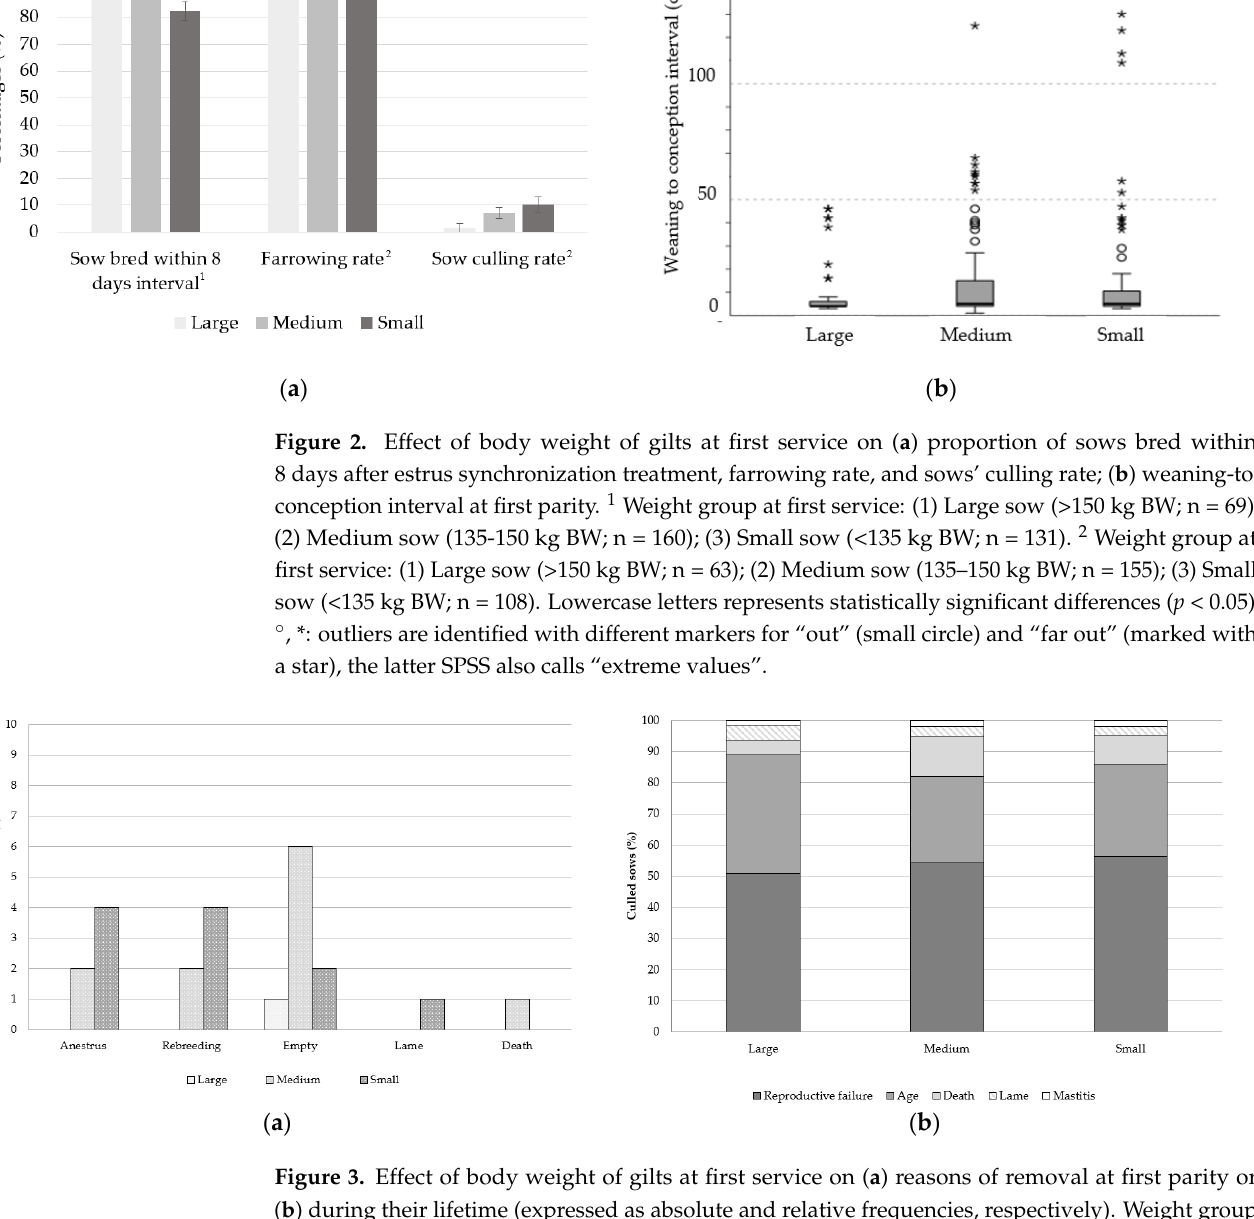
Figure 3. Effect of body weight of gilts at first service on ( a ) reasons of removal at first parity or ( b ) during their lifetime (expressed as absolute and relative frequencies, respectively). Weight group at first service: (1) Large sow (>150 kg BW; n = 63); (2) Medium sow (135–150 kg BW; n = 155); (3) Small sow (<135 kg BW; n = 108). No differences in reasons for culling throughout their lifetime were detected between weight groups of gilts ( p > 0.05).